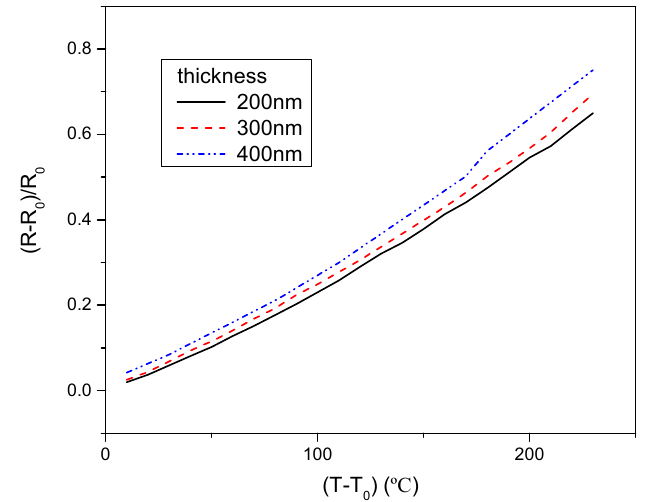
Figure 5. The temperature coe ffi cient of resistance (TCR) of the flexible hot film shear stress sensor with di ff erent thickness. Estimated accuracy for (R − R 0 ) / R 0 is ± 4 percent, for (T − T 0 ), ± 2 percent.